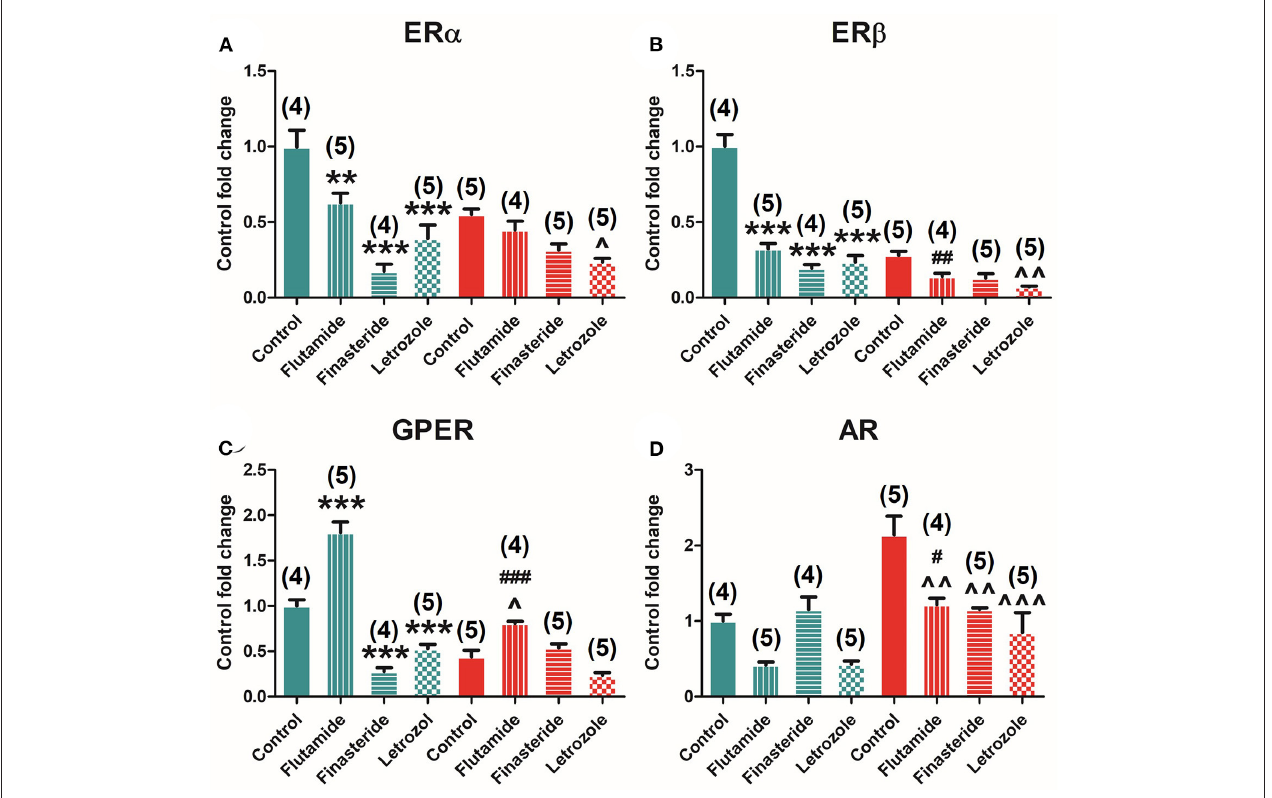
FIGURE 4 | Effect of flutamide, finasteride, and letrozole exposure on ER estrogen and AR expression in the pituitary gland in male and female animals. (A) ER α mRNA. (B) ER β mRNA. (C) GPER mRNA. (D) AR mRNA expression levels in male and female animals. Green bars represent male and red bars represent females. Control male ( n = 4), flutamide male ( n = 5), finasteride male ( n = 4), letrozole male ( n = 5), control female ( n = 5), flutamide female ( n = 4), finasteride female ( n = 5), letrozole female ( n = 5). Data are represented as mean ± SEM. **, ***Significant differences (** p < 0.01, *** p < 0.001) vs. male control values; ∧ , ∧∧ , ∧∧∧ Significant differences ( ∧ p < 0.05, ∧∧ p < 0.01, ∧∧∧ p < 0.001) vs. female control values; # , ## , ### Significant differences ( # p < 0.05, ## p < 0.01, ### p < 0.001) comparing female flutamide vs. male flutamide